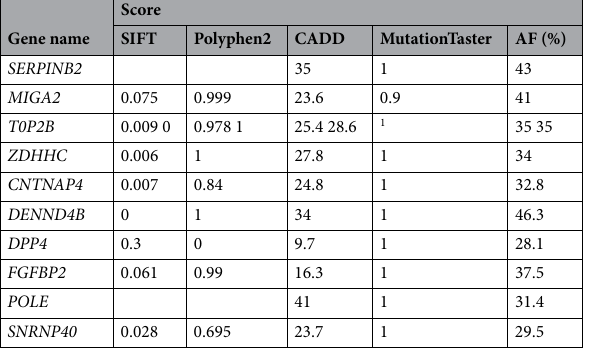
Table 4. Overview about pathogenicity prediction scores and the allele frequencies (AF). CADD: Combined Annotation Dependent Depletion. The scores were used to select interesting and relevant mutations. SIFT: Sorting Intolerant From Tolerant.